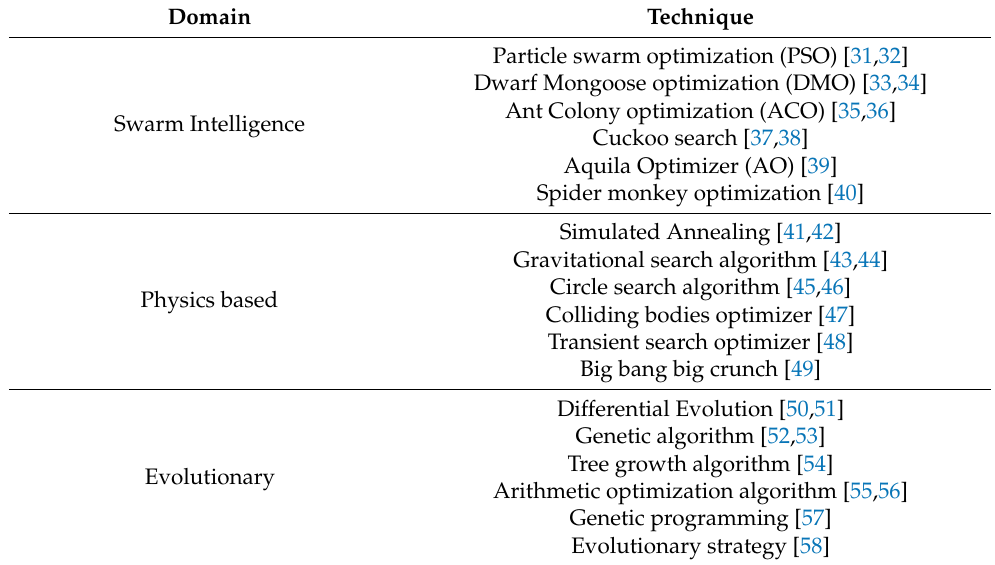
Table 1. Classification of metaheuristics.